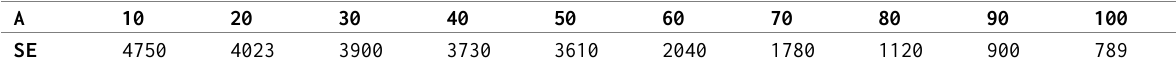
Table 1: Speed of Emergence Scores (Se) in Line with Several Deployed Agents(A)